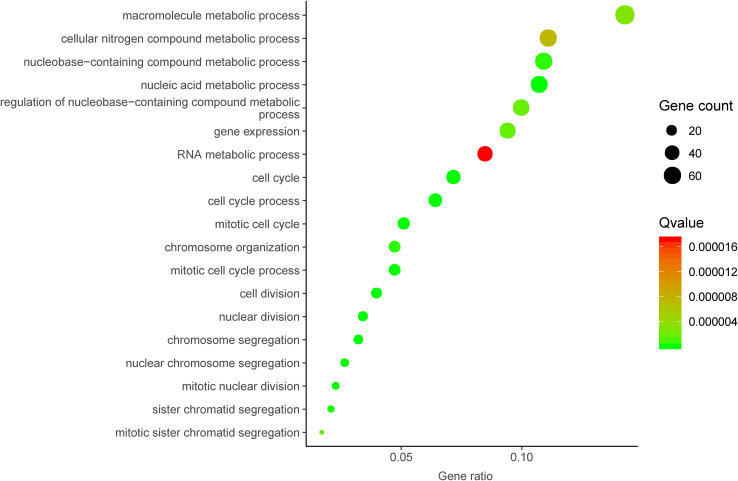
Bioinformatics analysis of DUXAP8 in HCC.